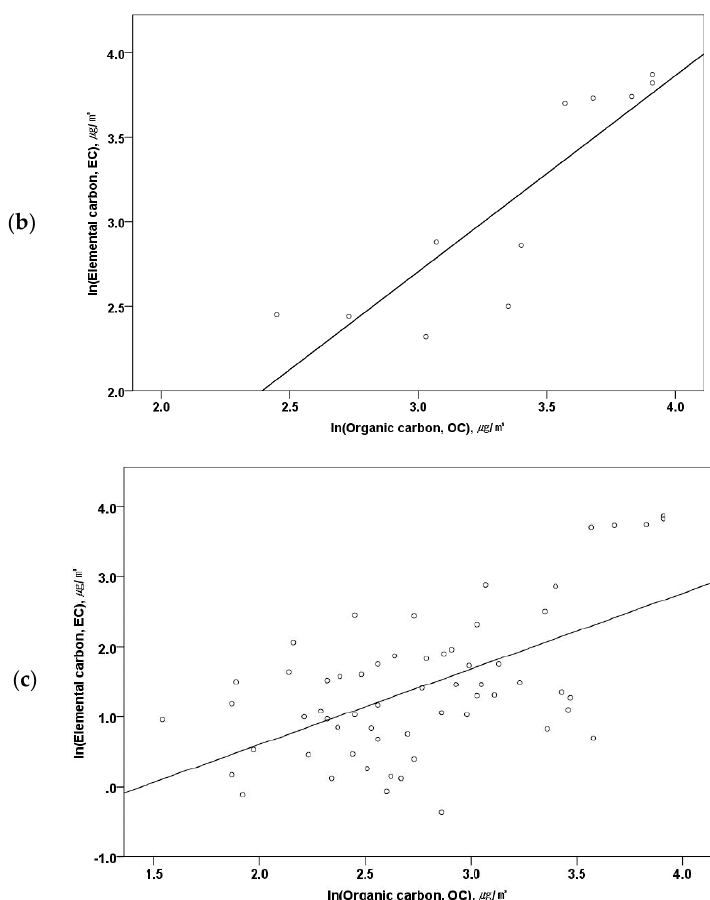
Figure 3. Correlation of EC and OC by EC exposure level: ( a ) EC < 10 µ g / m 3 (r = 0.199, p = 0.171), ( b ) EC ≥ 10 µ g / m 3 (r = 0.874, p < 0.01), ( c ) EC data all (r = 0.582, p <